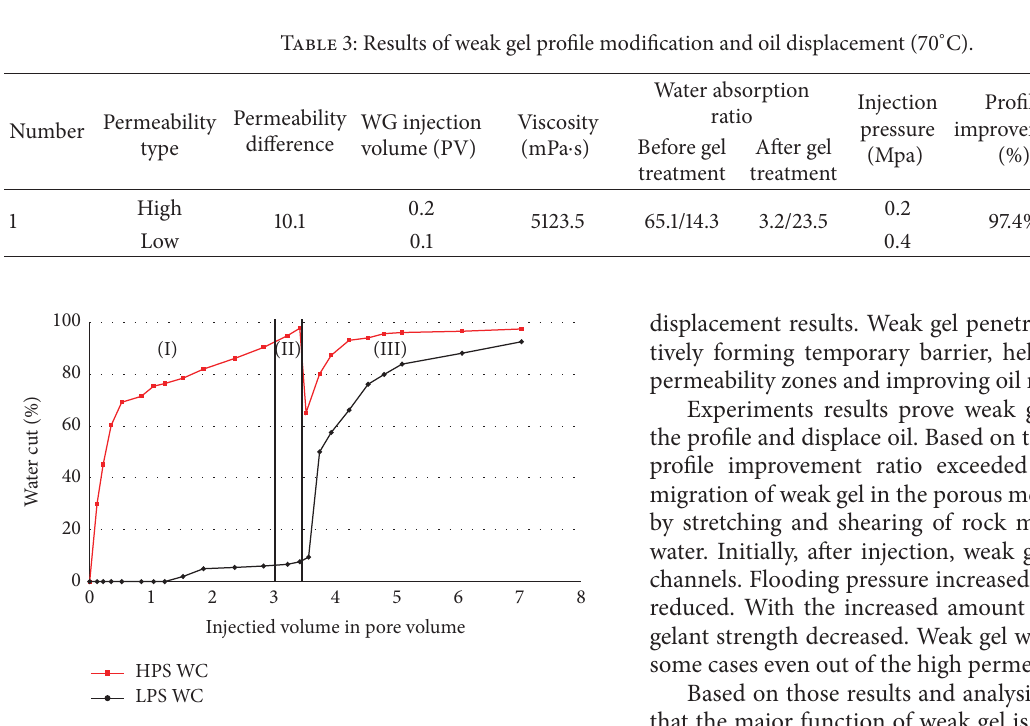
injected, 72 h shut in for gel forming (conditions identical with